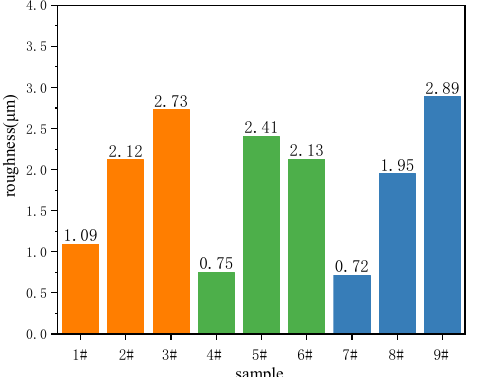
Figure 4. Surface roughness (Ra) of black MAO coating samples 1 # − 9 # .